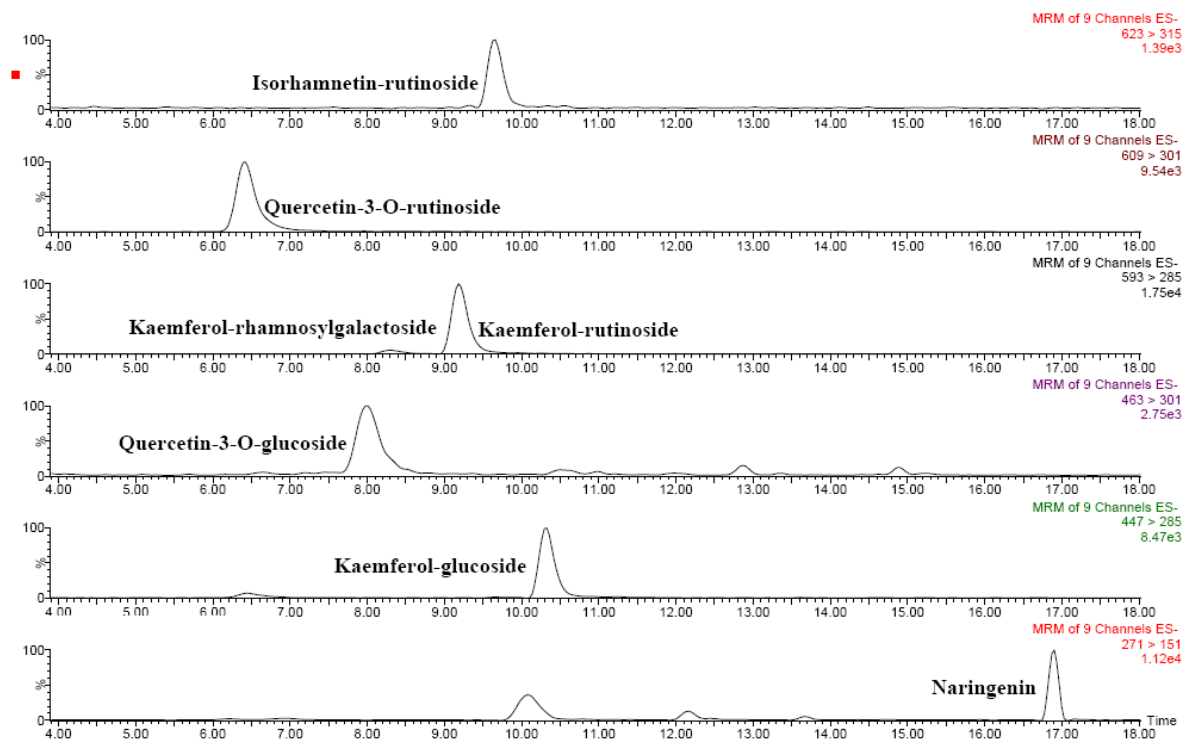
Figure 3. HPLC-ESI-MS/MS chromatograms of main flavonoids in red Solanum indicum L..